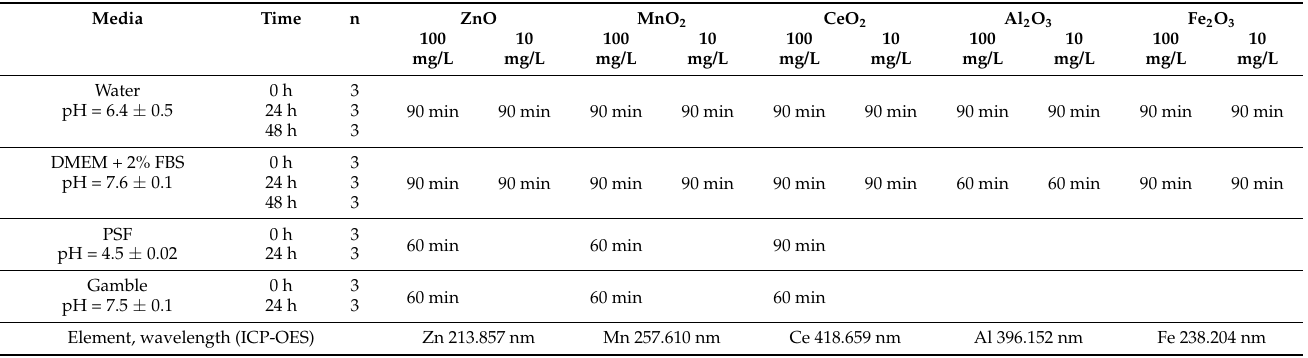
Table 1. Dissolved metal separation details for each metal-oxide ENM and media. Times used for undissolved particle separation by sequential centrifugation at 20,000 × g (60 min/90 min